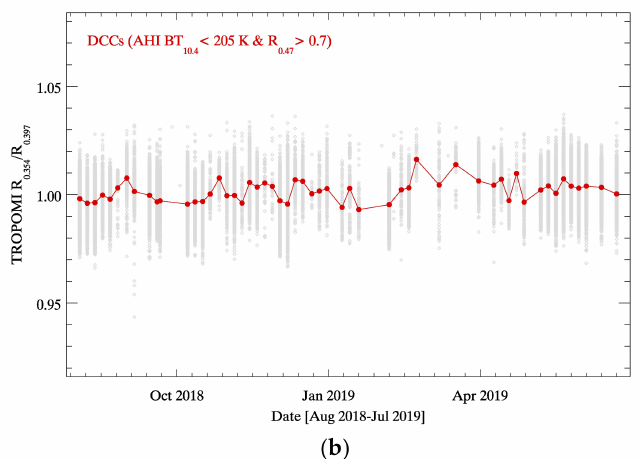
Figure 15. ( a ) Probability density function for TROPOMI R 0.354 over time (MAM: March to May; JJA: June to August; SON: September to November; DJF: December to February) and ( b ) time series of mean reflectivity ratio of R 0.354 and R 0.397 (grey diamonds are individual values) for the DCCs detected using the updated DCC detection